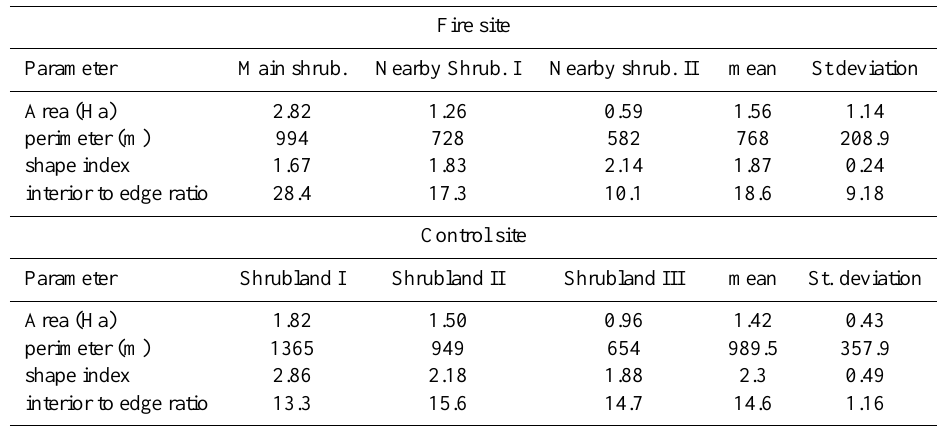
Table 2. Landscape metrics estimated for the studied Fabiana imbricata shrubland patches.